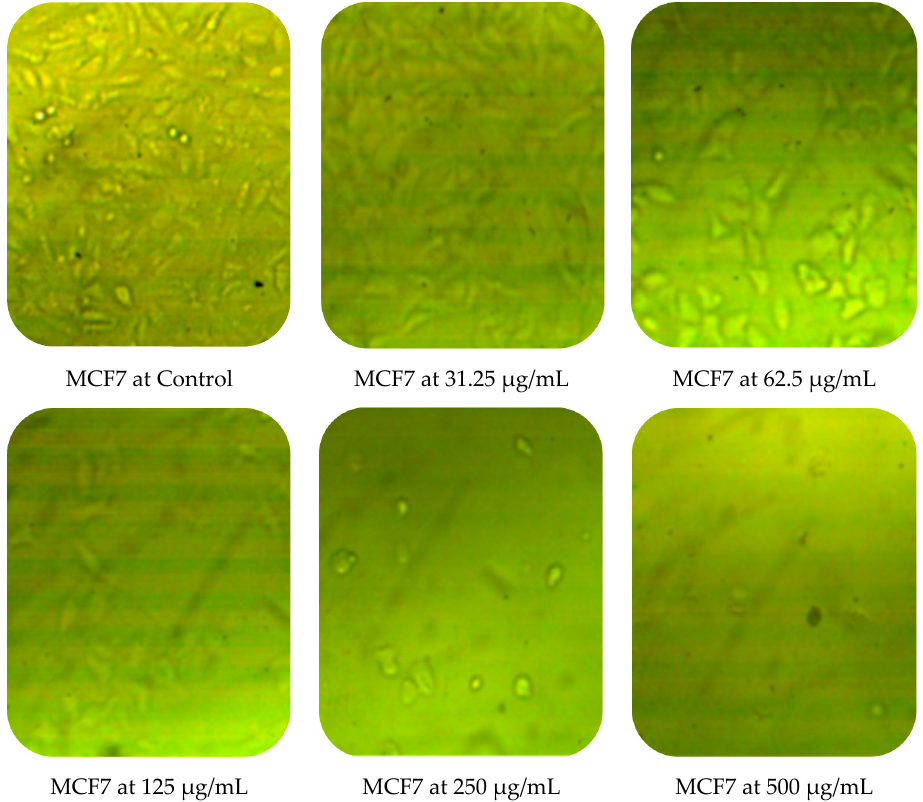
Figure 10. Effects of different concentrations of M. pulegium extract on morphological changes of PC3 and MCF7.